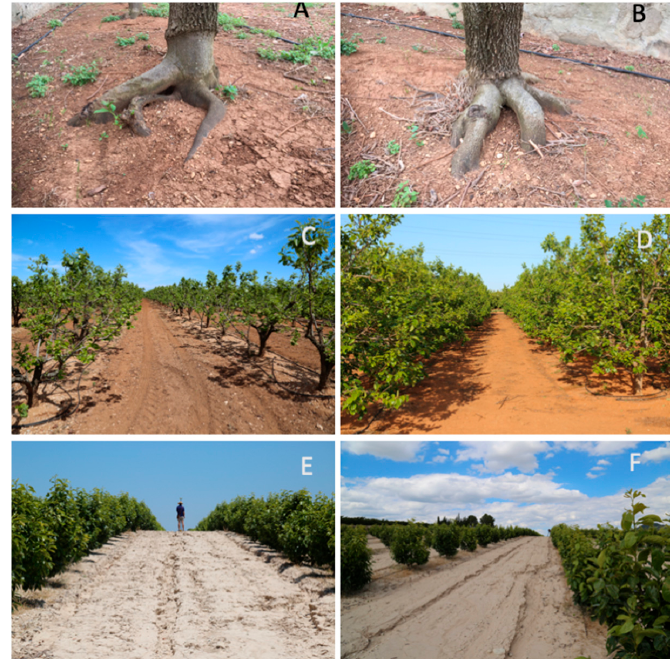
Figure 1. View of persimmon plantations in Eastern Spain. ( A , B ): root exposure in the “La Canyadeta” experimental station in Canals; ( C , D ): bare soils in two different parcels in Benimodo and L’Alcúdia; and, ( E , F ): view of the 4-year-old persimmon plantations in Moixent after a thunderstorm of 30 mm in 30 minutes.